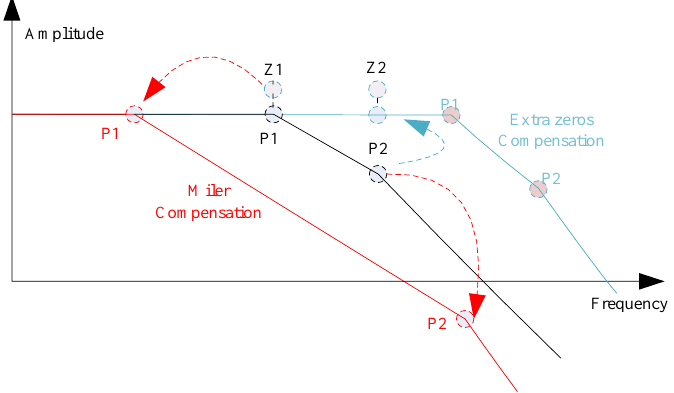
Figure 6. Frequency response for Miller compensation and the proposed compensation.